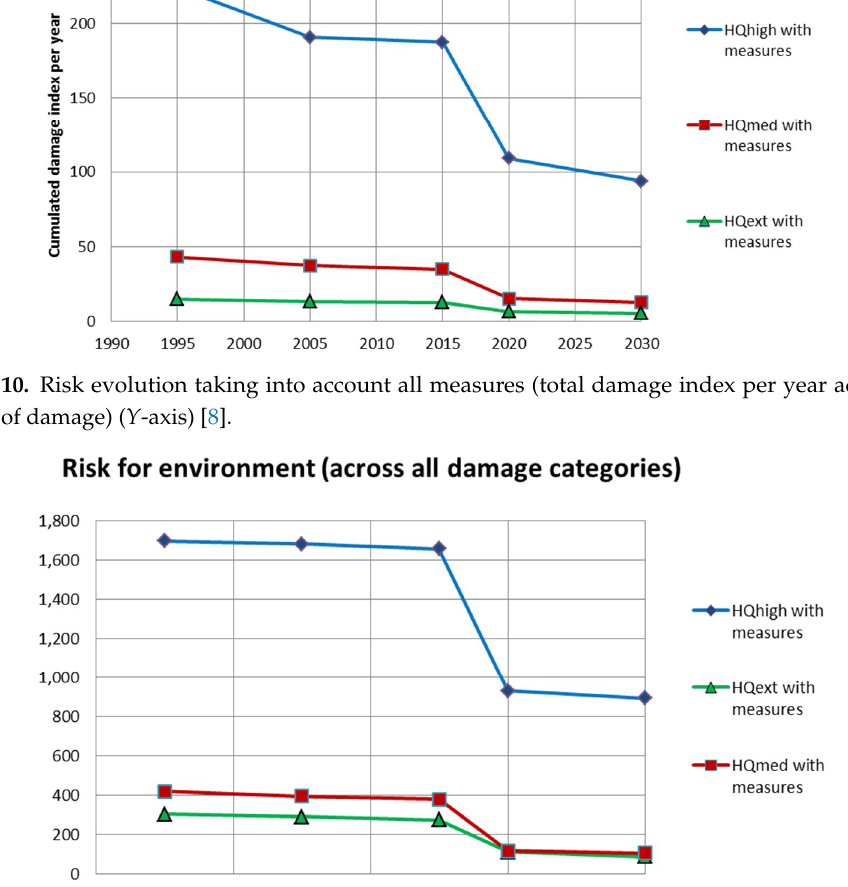
Figure 11. Risk evolution taking into account all measures (total damage index per year across all classes of damage) ( Y -axis) [8].